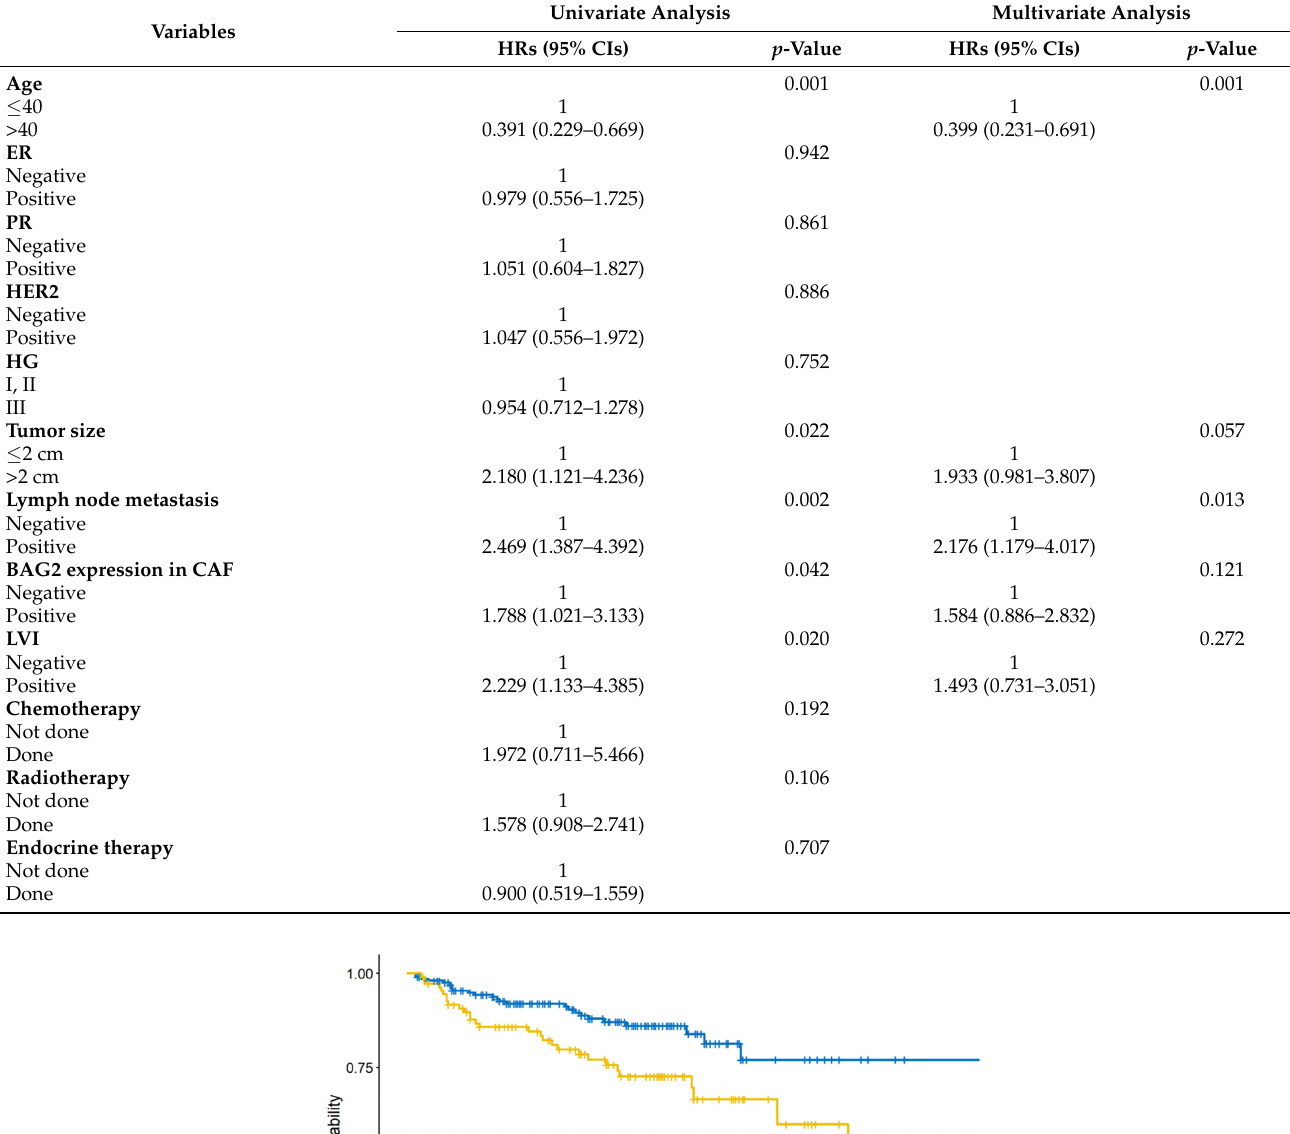
Table 2. Hazard ratios (HRs) and 95% confidence intervals (CIs) for distant metastasis-free survival (DMFS). Variables